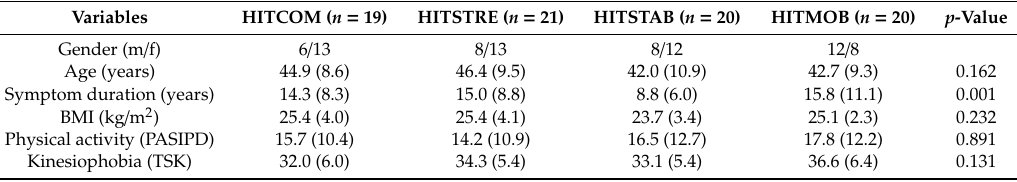
Table 1. Demographic and clinical characteristics of participants at